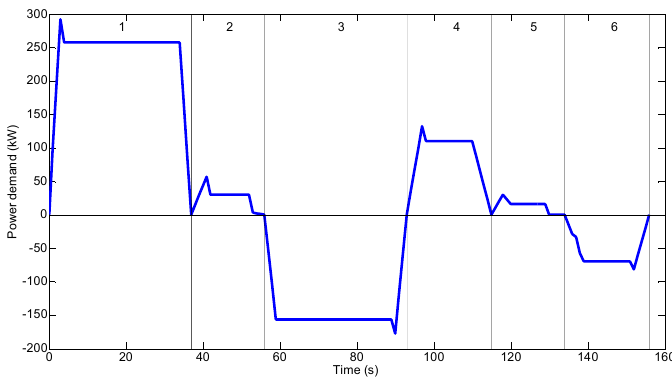
Figure 2. Power demand for rubber ‐ tired gantry (RTG) crane to operate a rated 40 ‐ ton container.